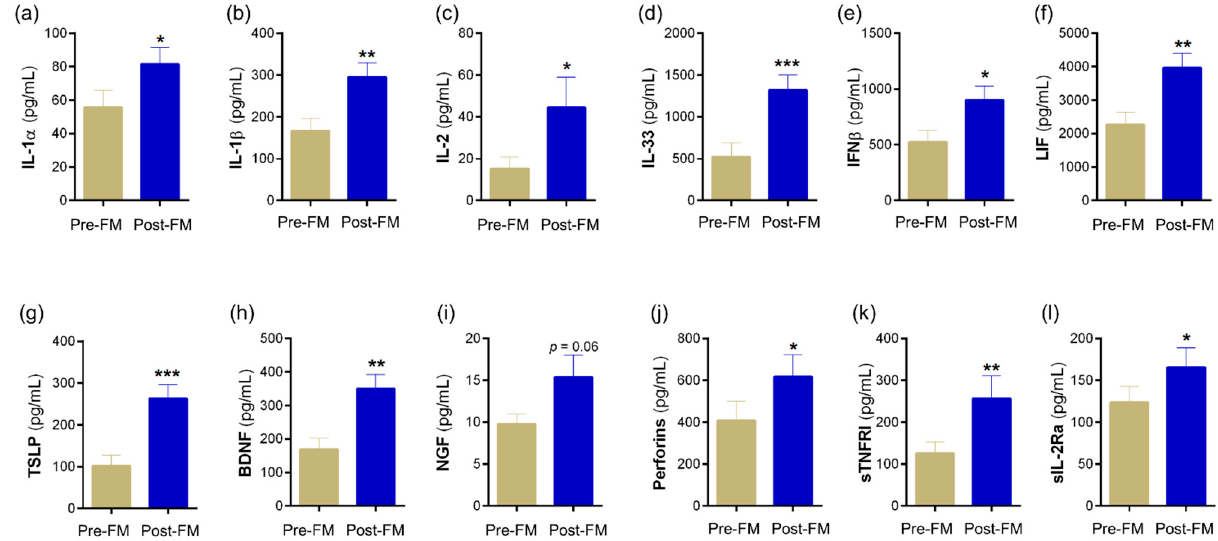
Figure 2. Tear fluid soluble factors increased during face-mask-wearing era. Bar graphs represent